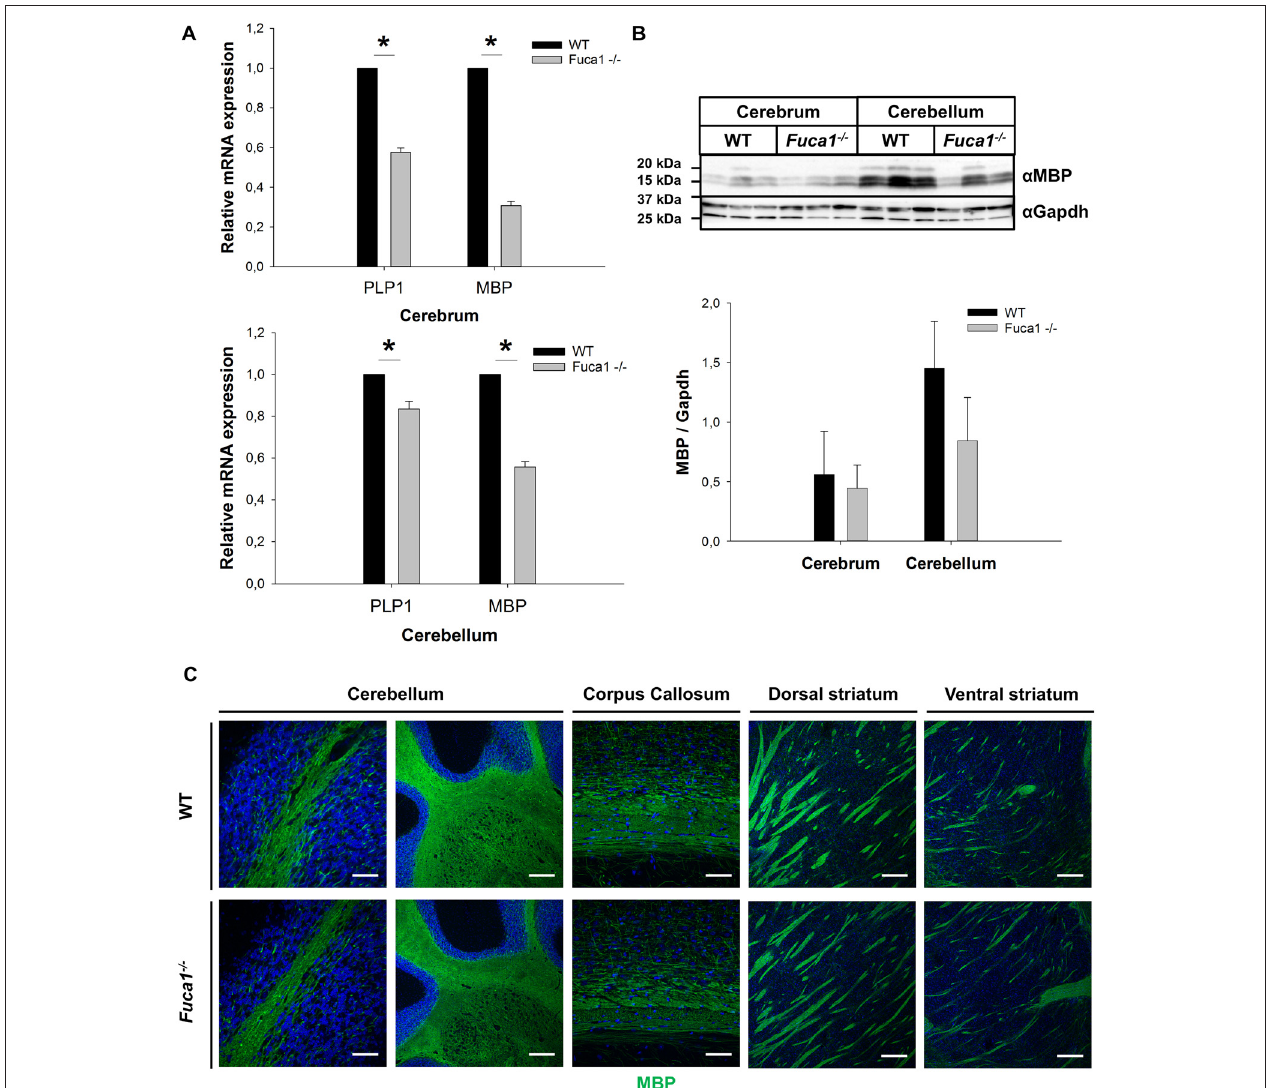
FIGURE 3 | Reduced Plp1 and MBP mRNA expression but intact myelination in the brain of Fuca1-deficient mice. (A) Quantitative PCR analysis of mRNA from cerebrum and cerebellum revealed decreased levels of Plp1 and MBP in 3-month-old Fuca1-deficient mice. (B) Tissue homogenates from cerebrum and cerebellum were separated by SDS-PAGE and blotted onto PVDF membrane. After blotting, the membrane was cut and the part of the membrane representing proteins smaller than 25 kDa was analyzed for MBP. The amount of MBP was not significantly lower in the Fuca1 gene knock-out as shown by immunoblotting of cerebral and cerebellar tissue homogenates of 3-month-old mice (mean ± SD, n = 3). Gapdh was used for normalization. The Gapdh results shown here and in Figure 2B are identical, as the same blot was used for the analyses. (C) Myelination is unaffected in the Fuca1 gene knock-out as shown by immunofluorescence staining of MBP in brain sections of 3-month-old mice. The cell nuclei were stained with DAPI. Scale bars = 200 µ m (cerebellum (left panel) and striatum) or 50 µ m (cerebellum (right panel) and corpus callosum). Asterisk indicates significance of